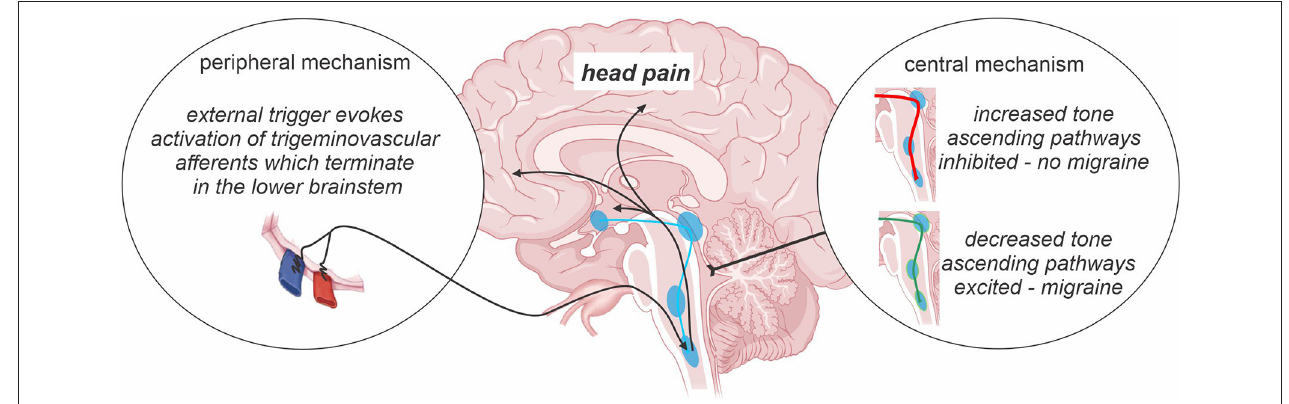
FIGURE 1 | Central vs. peripheral mechanism of migraine. The prevailing theories of migraine initiation include the existence of a peripheral trigger and/or central nervous system changes including oscillations in the sensitivity of descending pain modulatory pathways across the migraine cycle. Such changes in brainstem “tone” are proposed to either prevent or allow an external trigger or basal brainstem activity from evoking activity changes in ascending pathways which are ultimately responsible for the presence of a migraine